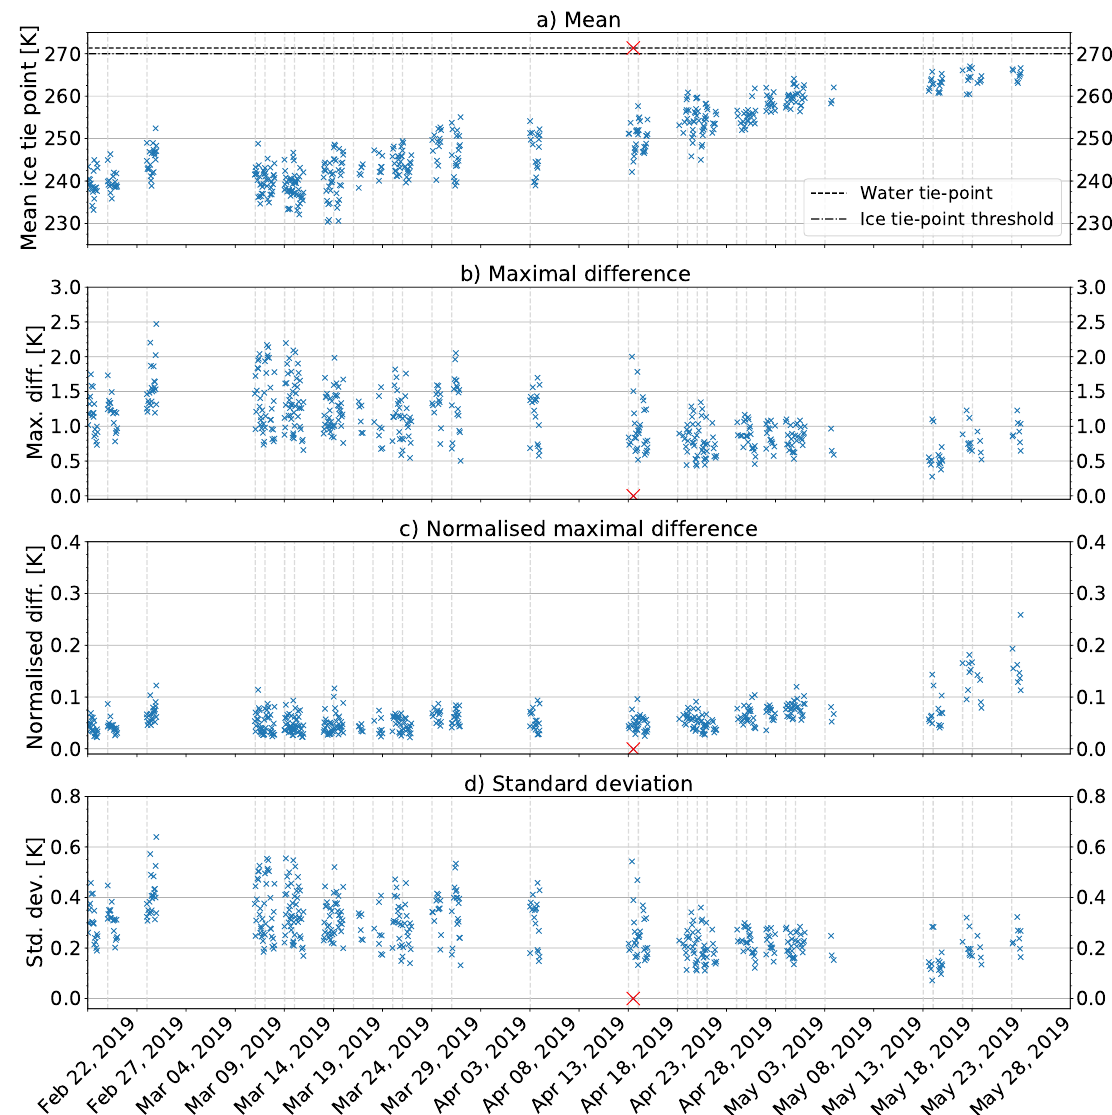
Figure 4. Effect of shifting the starting position of the box used for the ice tie-point calculation. The starting position is shifted by one pixel before redoing the calculation, so that each pixel is covered 48 times. The x-axis shows the date; the vertical lines mark the days with Sentinel-2 scenes. Panel ( a ) shows the mean of the 48 iterations, same as in Figure 3b. The dashed horizontal line shows the water tie-point. The dash-dotted line gives a discarding threshold. If the ice tie-point is above this threshold, no SIC is derived in the current version of our retrieval. As in Figure 3, red crosses mark the granules above this threshold. Panel ( b ) shows the difference between the maximal and minimal ice tie-point. Panel ( c ) also shows the maximal difference, but normalised by the dynamic range (difference between ice and water tie-point). Panel ( d ) shows the standard deviation of the 48 iterations, also normalised by the dynamic